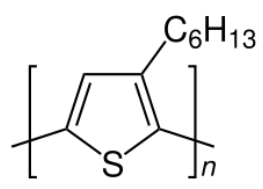
Figure 1. Scheme of the P3HT monomeric unit.